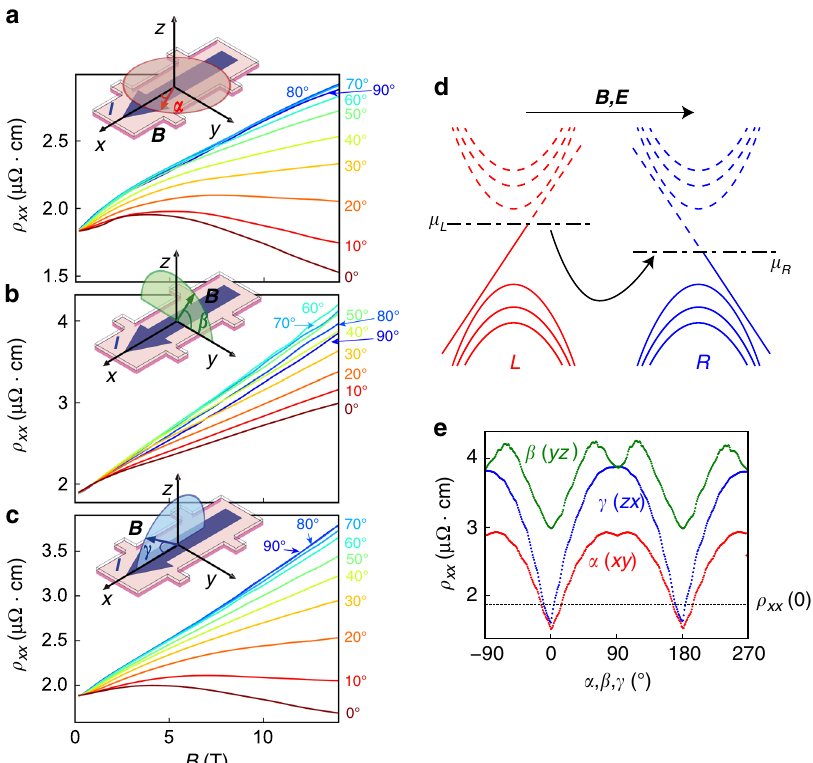
Fig. 2 Chiral anomaly in the transport of SrRuO 3 . a – c , MR ρ xx ( B ) at B angles α ( a ), β ( b ), and γ ( c ) at 2 K for the SrRuO 3 fi lm with the RRR of 84.3. Angles α , β , and γ are de fi ned in the insets of ( a – c ). d Schematic image of the chiral-anomaly induced negative MR. Red and blue bands represent Landau levels of a pair of Weyl nodes with opposite chiralities L and R, respectively. Non-orthogonal electric and magnetic fi elds ( E · B ≠ 0) lead to the chiral charge transfer between the two Weyl nodes with opposite chiralities (L and R). The currents of the chiral charges are observed as a form of negative MR. Here, μ L and μ R indicate chemical potentials in the Weyl points with opposite chiralities. e α - , β - , and γ - angular dependences of the MR ρ xx with B = 14 T at 2 K for the SrRuO 3 fi lm with the RRR of 84.3. The black dashed line indicates the ρ xx (0 T) value. The region below the black dashed line shows negative